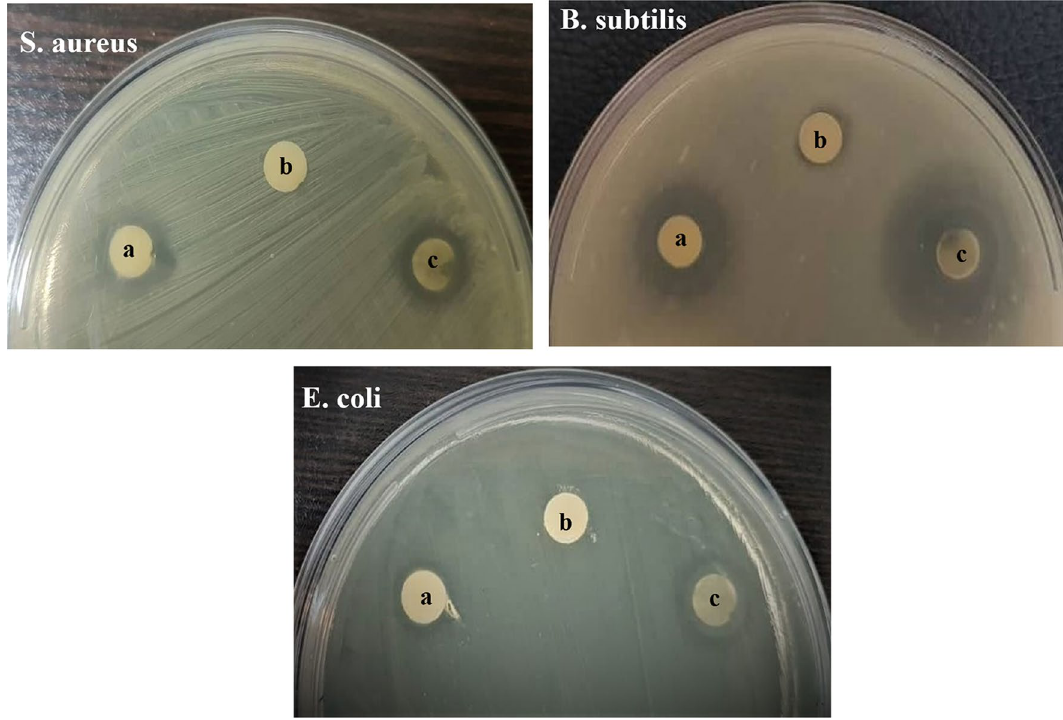
Figure 16. Antibacterial assay of synthesized ZnO ( a ), ZnO/Chitosan ( b ) and MWCNTs/ZnO/Chitosan ( c ) sample discs on S. aureus , B. subtilis and E. coli